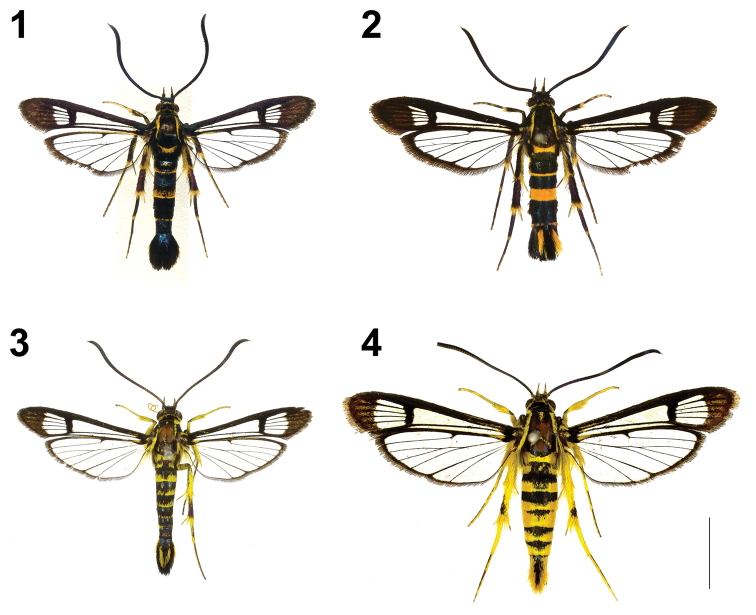
Synanthedonini adults 1, 2Synanthedonauritinctaoidis sp. nov. 1 ♂, holotype, Taiwan: Hualien (NHMUK). 2 ♀, paratype, Taiwan: Hualien (NTNU). 3, 4Paranthrenellahelvola sp. nov. 3 ♂, holotype, Taiwan: Nantou (NHMUK) 4 ♀, paratype, Taiwan: Nantou (NTNU). Scale bar: 10 mm.